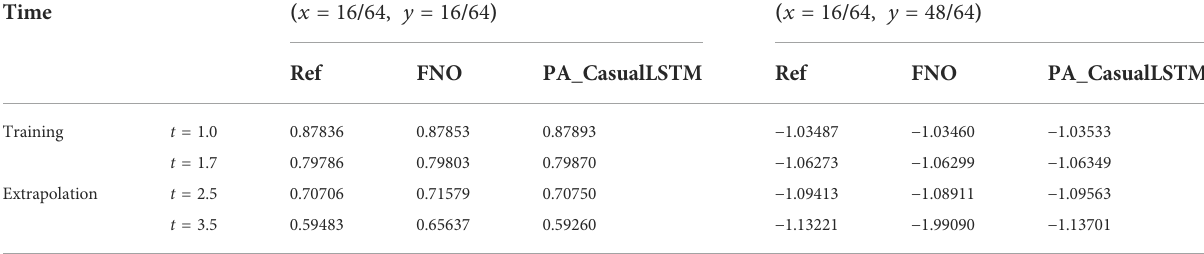
TABLE 2 Numerical results of vorticity for 2D Navier – Stokes equations solved by the classical numerical method, FNO, and PA_CasualLSTM.